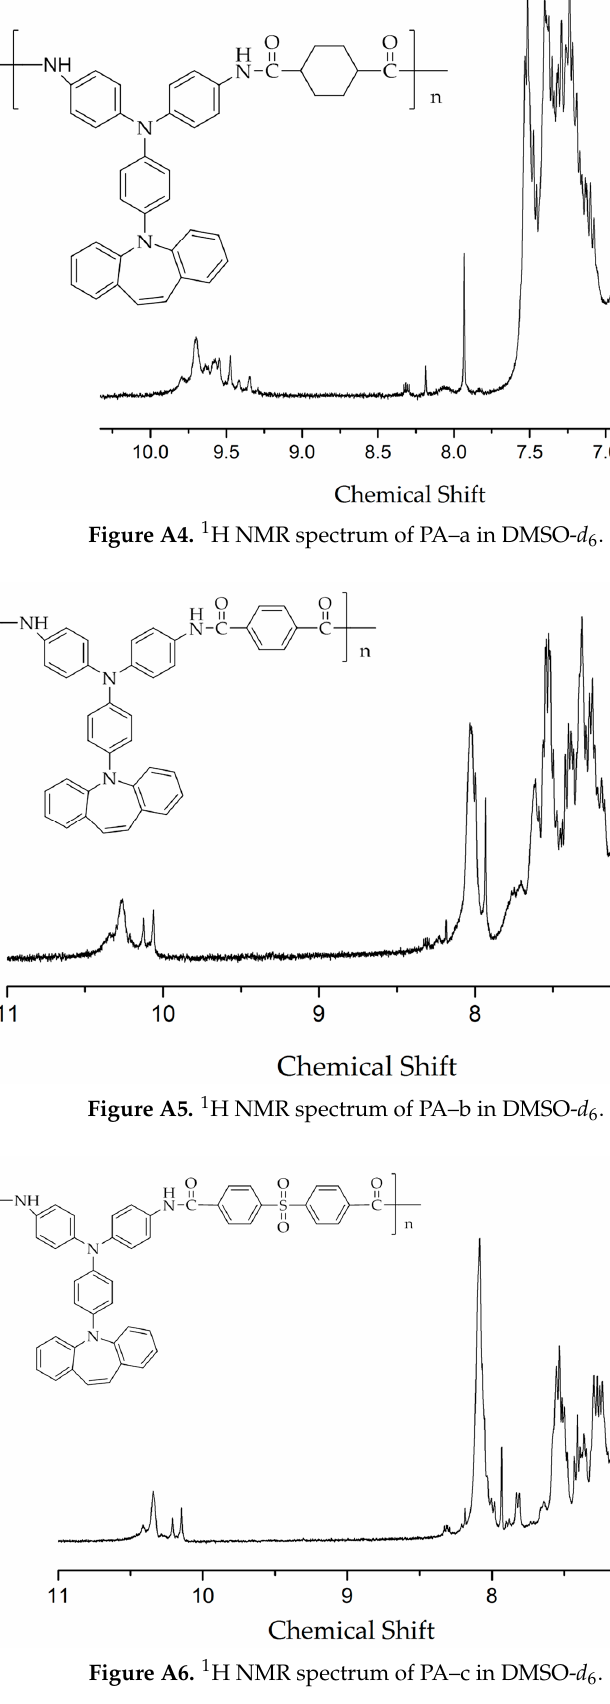
Figure A3. 1 H NMR spectrum of M3 in DMSO- d 6 .